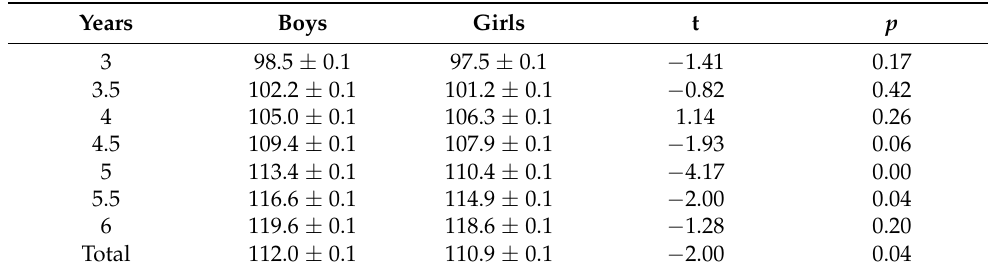
Table 2. Gender difference in height ( X ± SD,